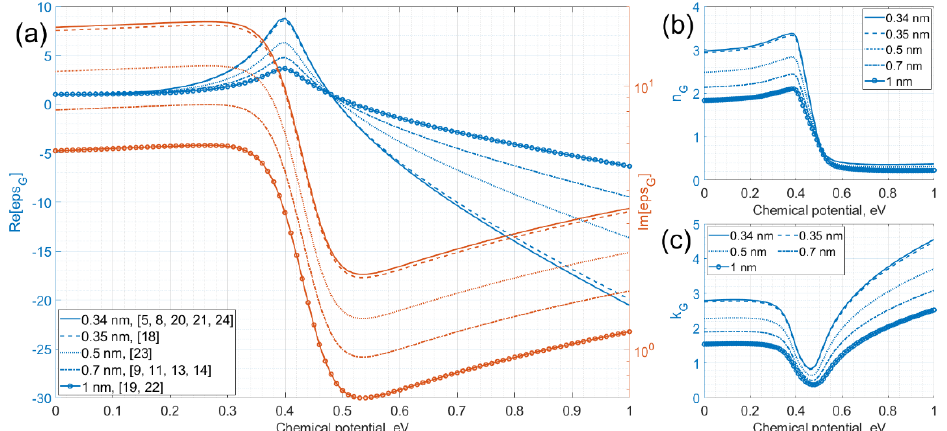
Figure 2. ( a ) Real (blue curves) and imaginary (red curves) parts of the permittivity, ( b ) refractive index and ( c ) extinction coefficient as a function of chemical potential for different GE thicknesses from various publications ( λ = 1.55 µ m, t G = 0.34 ÷ 1 nm, µ c = 0 ÷ 1 eV, Γ = 8e13 s − 1 , T = 300 K).